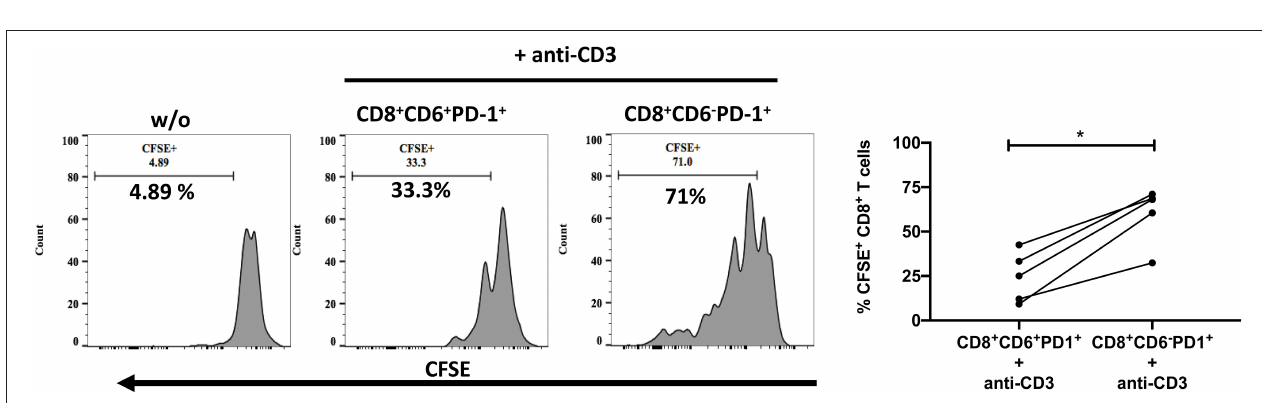
FIGURE 4 | Overexpression of CD6 and PD-1 is associated with reduced cytokine secretion. Representative staining and the frequency of splenic CD6 + PD-1 + and CD6 − PD-1 + CD8 + T-cells expressing IL-2 and TNF- α in vivo . Data are from 4 macaques. Data are shown as means ± SEM. For statistical analysis, Mann-Whitney tests were performed. * p < 0.05.